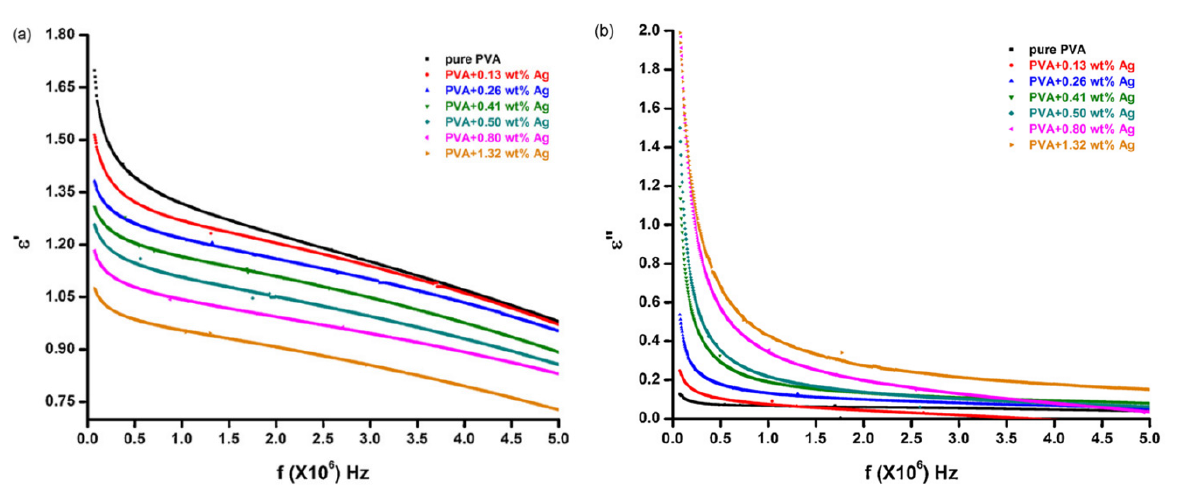
Figure 25. ( a ) Variation in dielectric constant ( ε′ ) with frequency for different concentration (wt %) of Ag nanoparticles in PVA. ( b ) Variation in dielectric loss factor ( ε″ ) with frequency for different concentration (wt %) of Ag nanoparticles in PVA. (Reproduced with permission from [98], Copyright Elsevier